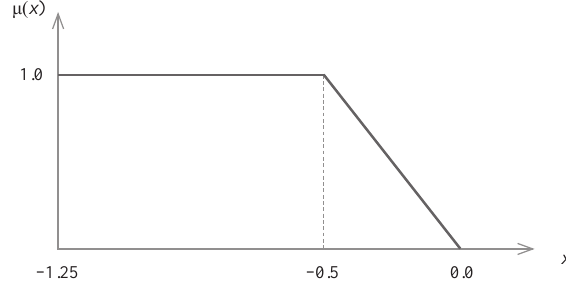
Fig. 9. Membership function of negative NPW